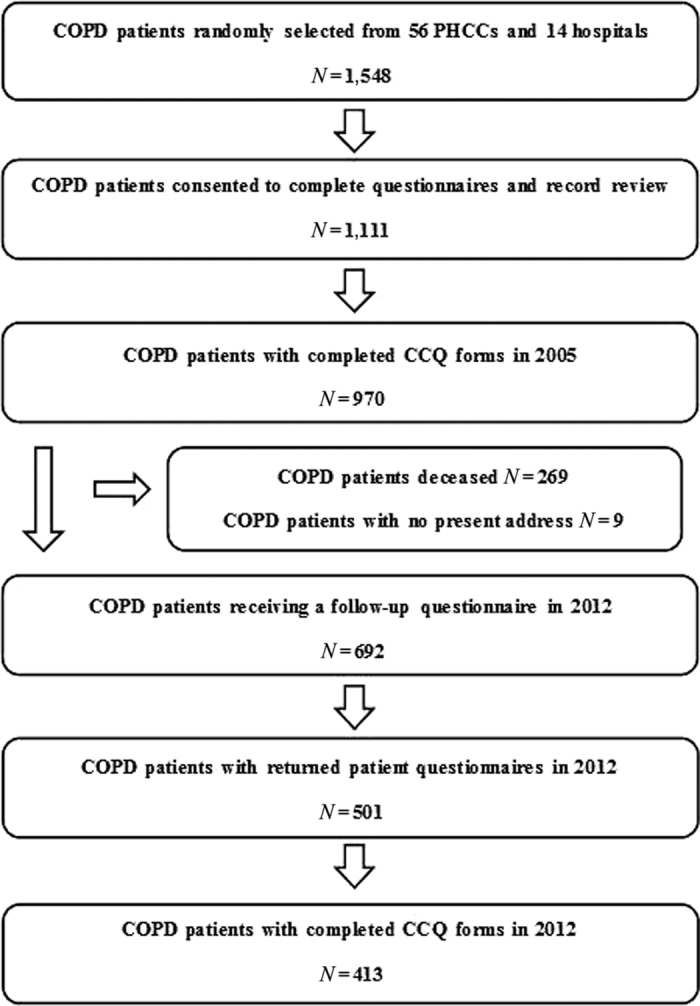
Flow chart. CCQ, Clinical COPD Questionnaire; COPD, chronic obstructive pulmonary disease; PHCC, primary health care centre.